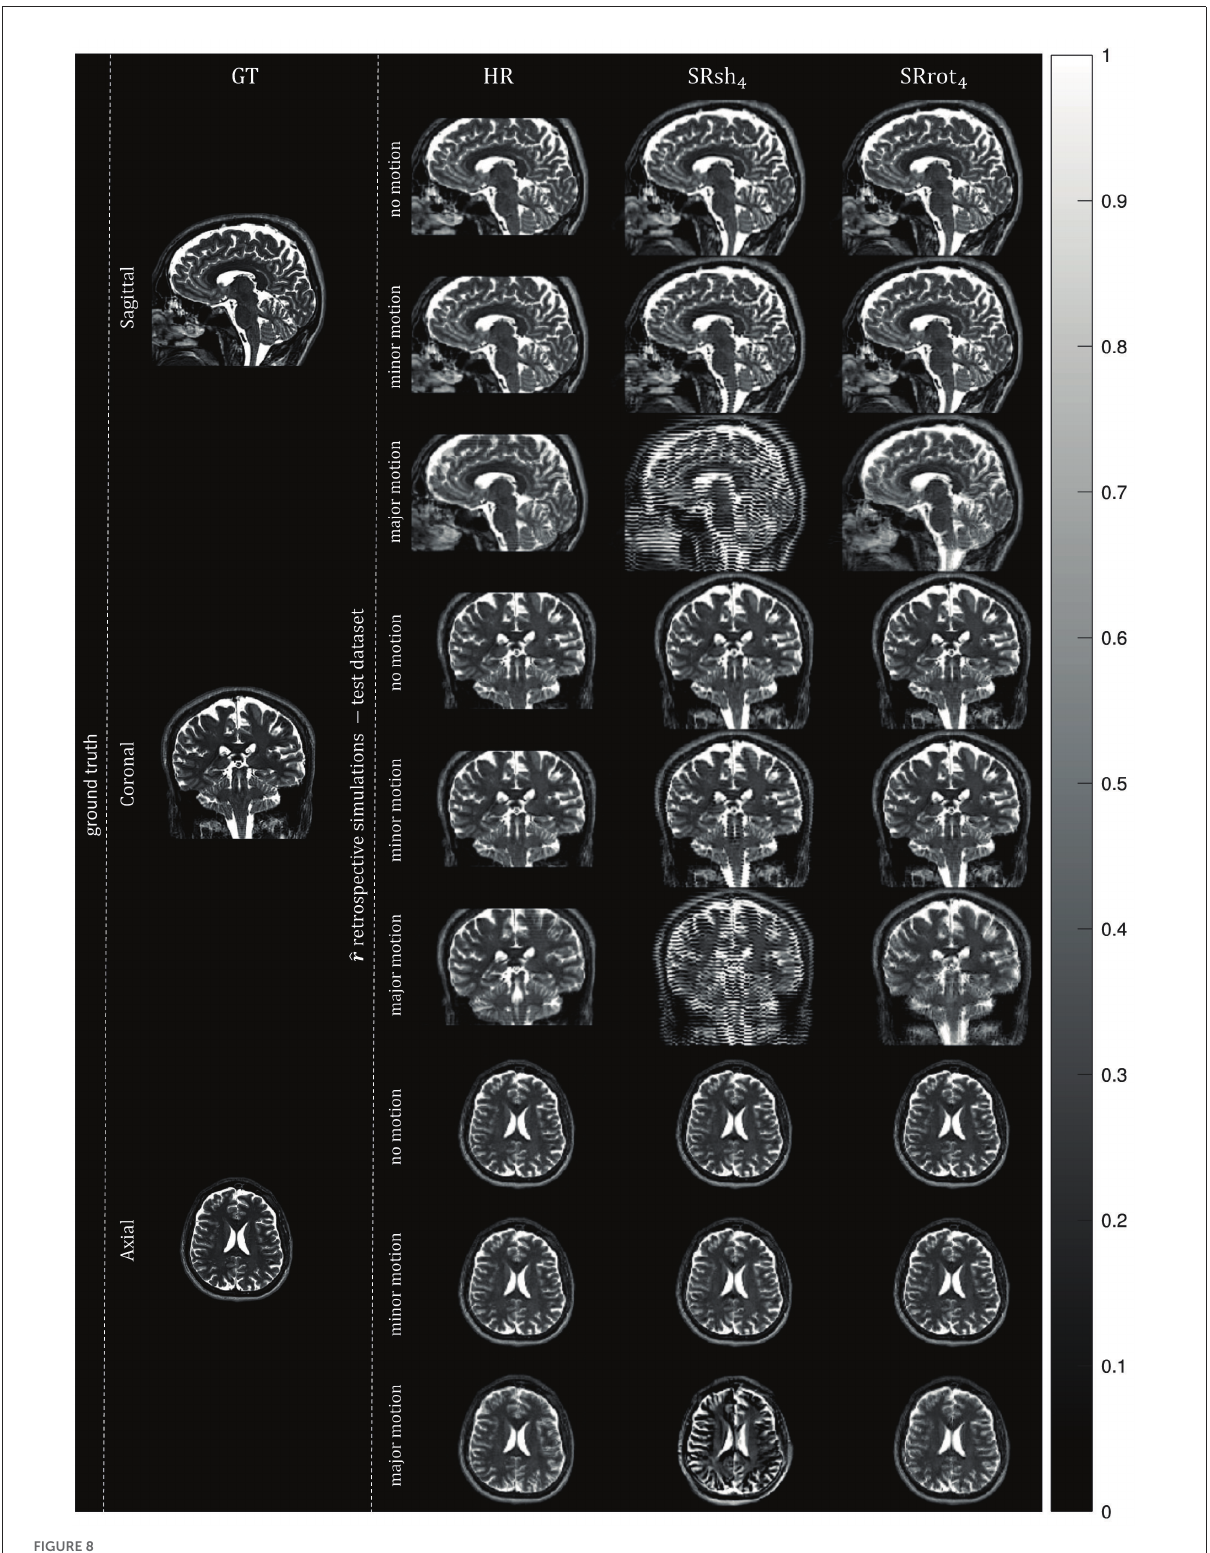
FIGURE8 Retrospective simulation results: MS-SRR images. The views from orthogonal planes of the ground truth image, which corresponds to the MS-SRR image estimated from all the pre-processed acquired MS images from all the protocols simultaneously, and the MS-SRR images estimated from the test dataset for each protocol in the absence of motion ( σ mot 0 mm / ◦ ) and in the presence of motion levels equal to the = upper bounds of the minor ( σ mot 0.1 mm / ◦ ) and major ( σ mot 1 mm / ◦ ) motion ranges are = =